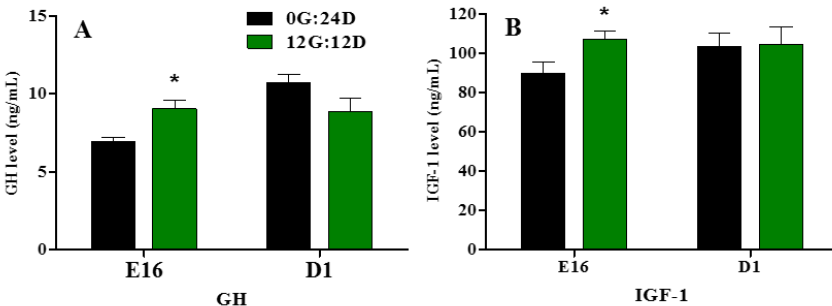
Figure 3. Plasma GH and IGF-1 levels of goose embryos incubated in the dark or under monochro- matic green light. ( A ) Plasma GH levels. ( B ) Plasma IGF-1 levels. Data are presented as mean ± SEM (n = 8 embryos per group). Means with asterisks show significant difference between the 2 groups on the same day (* p < 0.05).